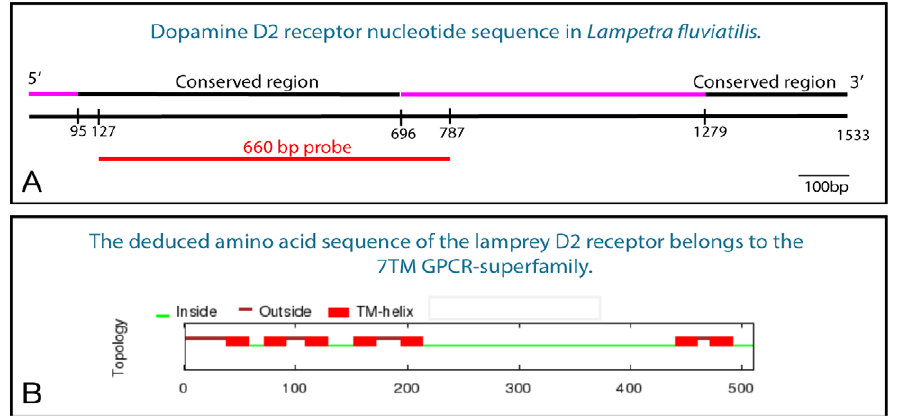
transmembrane domains (TM-helix) are all located at the conserved parts of the dopamine D2 receptor. The deduced amino acid sequence of the receptor shows that it belongs to the GPCR-superfamily.